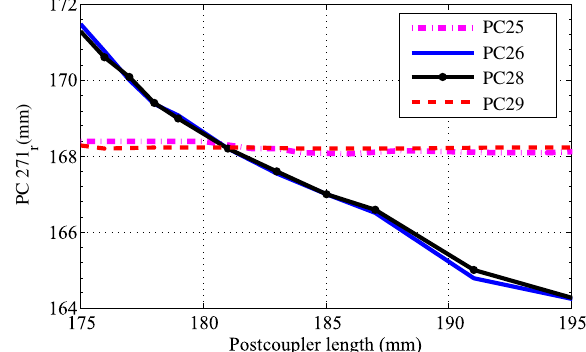
FIG. 5. The variation of TS 0 7 as a function of the length of post- coupler 7 l 00 7 . The behavior is well defined and can be fit using Eq.